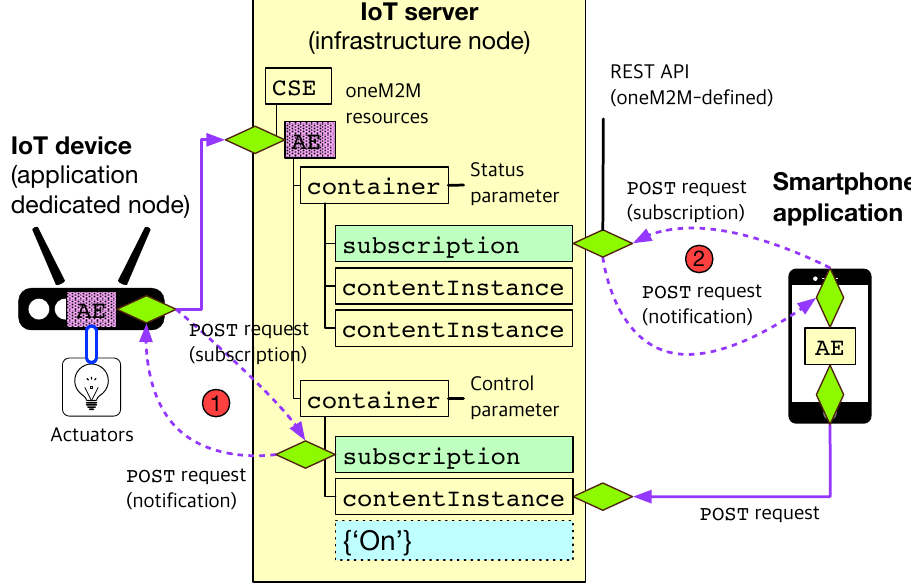
Figure 3. The proposed actuation scenario using oneM2M standard-based actuation